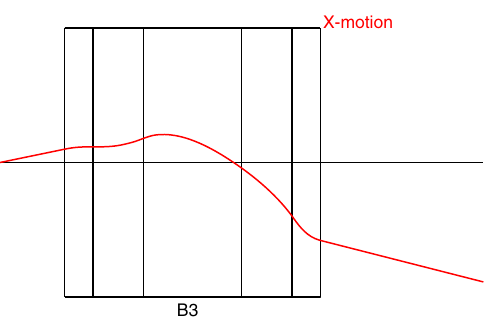
FIG. 6. In-plane ray with an initial angle 30 mrad from sweeper corresponding to an offset of 13.3 cm at the isocenter.